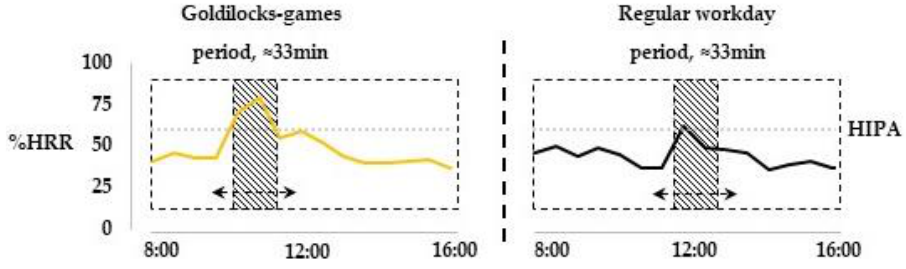
Figure 3. Illustration of the procedure used to compare time spent with HIPA during the Goldilocks-games and during a regular workday. The shaded area shows the periods compared with occurrence of HIPA .